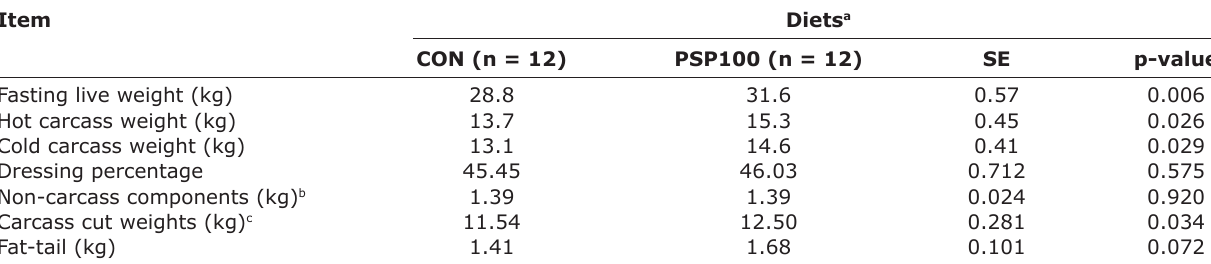
Table-3: Effects of feeding PSP on carcass and non-carcass components of Awassi lambs.